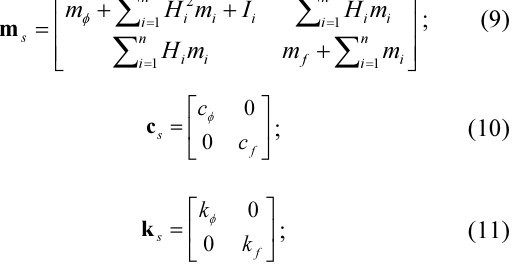
Horizontal Rocking )( . ( )